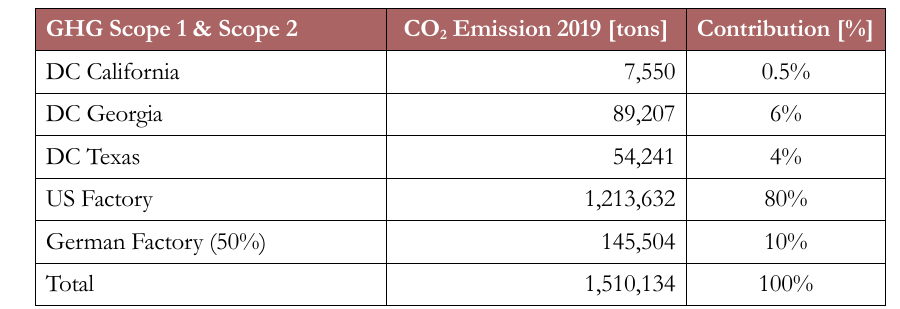
Table 4. Carbon emission split under GHG Scope 1 & Scope 2